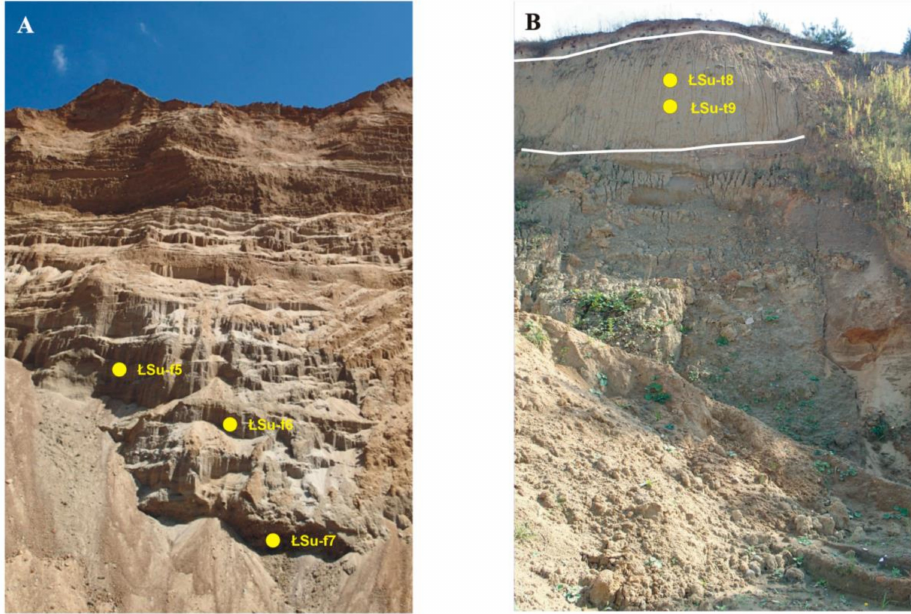
Figure 4. ( A ) Upper layers of outwash sediments (unit SŁ III) in a horizontal part of wall A; ( B ) Close- up of the upper till (unit SŁ IV) in a vertical part of wall A of the gravel